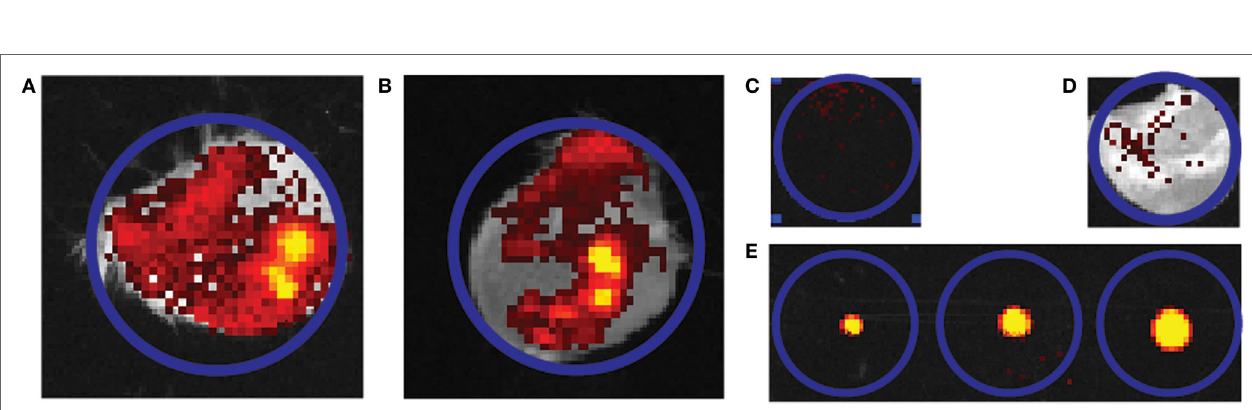
FigUre 4 | Representative quantification image of the delivery of fluorescently labeled antigen into mouse ears. (a,B) An overlay of picture of the mouse ear and infrared fluorescence imaging. Two independent ear piercing experiments are shown for diphtheria toxoid (DT) ( n = 2) (a) and tetanus toxoid ( n = 3) (B) . (c,D) Background fluorescence without and with mouse ear. (e) Gradient of solution containing 0.24, 0.6, and 1.2 Lf DT. Blue circles all indicate region of interest and have an equal diameter in all cases.